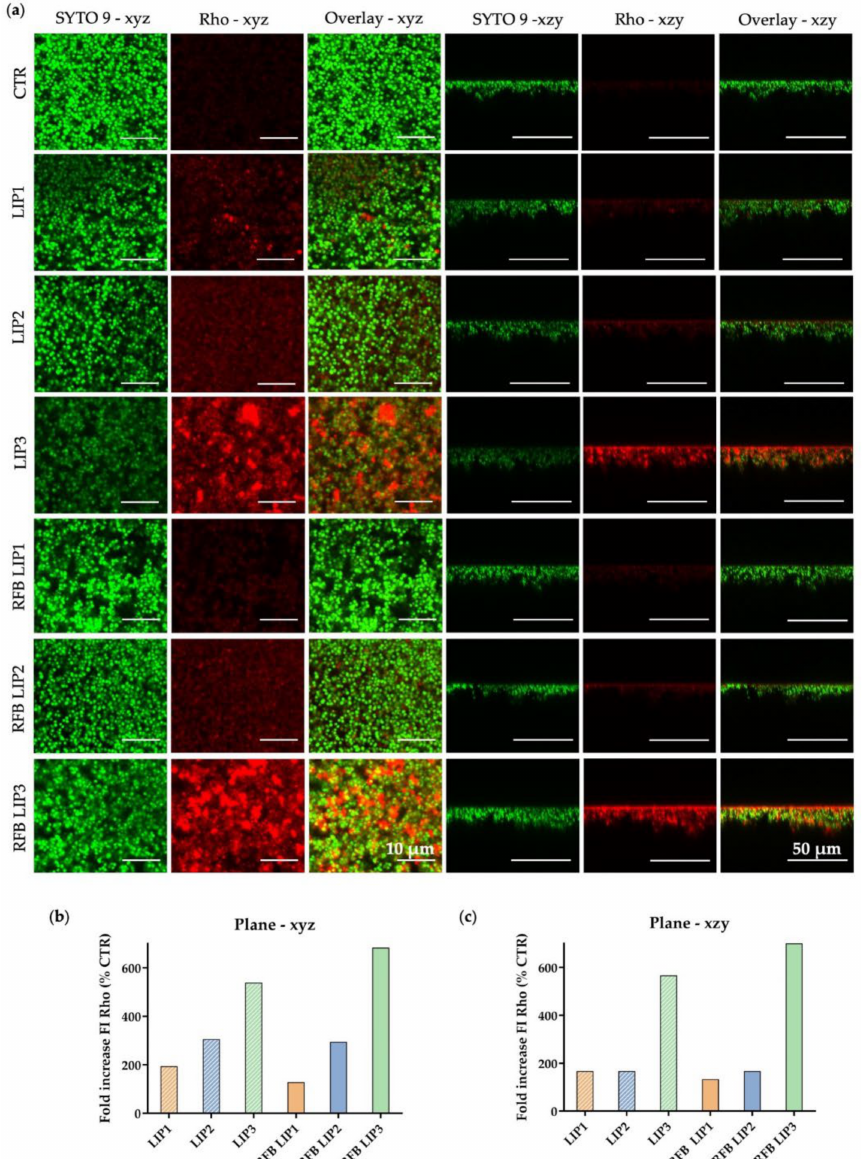
Figure 5. ( a ) Representative CLSM images of 24 h old biofilms incubated with unloaded or RFB- loaded liposomes labelled with Rho (LIP1, LIP2, LIP3, RFB LIP1, RFB LIP2 and RFB LIP3) at a lipid concentration of 1.5 µ mol/mL, during 4 h; Untreated 24 h old biofilm was used as a control (CTR). The biofilms were stained with the nucleic acid-binding dye (SYTO 9) at 3 µ M, (green). The panels of the left correspond to xyz plane images taken at the inner layer of MSSA stained biofilms and the right panels consist of xzy orthogonal plane images. The overlay of the green and red channels from xyz and xzy plane images is presented in the central and right panels, respectively. ( b , c ) Evaluation of the fluorescent intensity (FI) increase in relation to CTR, ( b ) in plane xyz and ( c ) in plane